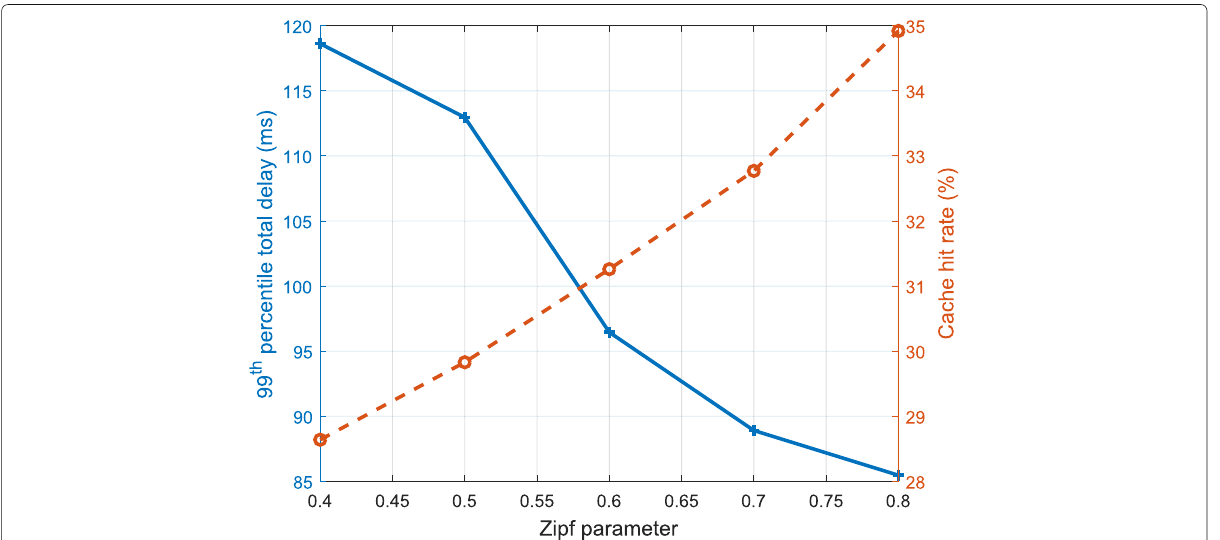
Fig. 7 The cache hit rate and delay performances vs. the popularity distribution. The 99th percentile delay and cache hit rate as the Zipf parameter z varies, with E = 30 cloudlets, UN density U / E = 3, and a storage size s e of